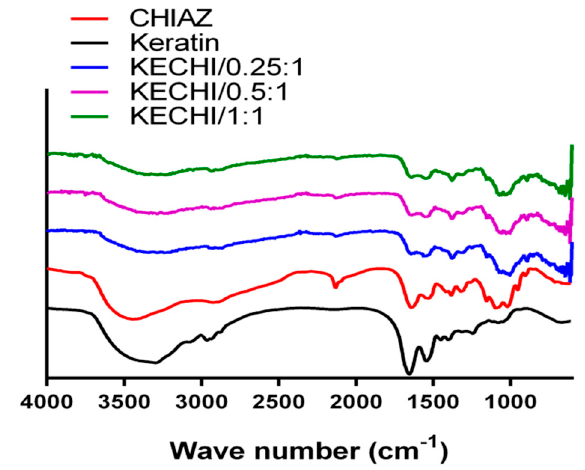
Figure 2. The FTIR results of keratin-chitosan membranes: Black: KECHI/0.25:1; Red: KECHI/0.5:1; Blue: KECHI/1:1.